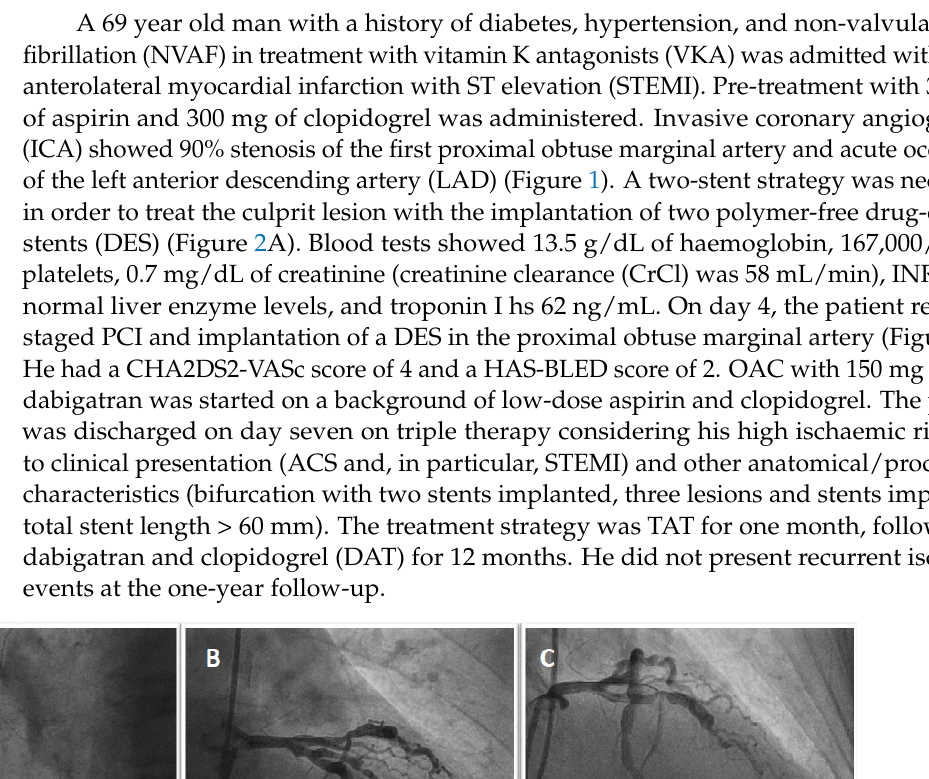
Figure 2. Final result after the first intervention with the implantation of two polymer-free DES on the mid-LAD and second diagonal branch (T stent technique; 2.75 × 24 mm and 2.25 × 14 mm) ( A ). Final result after the second intervention with implantation of a DES in the proximal obtuse marginal artery (2.5 × 25 mm) ( B ). 1.2. Patient 2 A 68 year old female presented with stable angina Canadian Cardiovascular Society (CCS) grading III and positive stress-echocardiography was referred to ICA. She had not well-treated hypertension, hypercholesterolemia, and chronic kidney disease (CKD). She also reported a history of palpitations and, 3 years before admission, an episode of melena. Laboratory data showed 10 g/dL of haemoglobin, 155.000/mL of platelets, 1.2 mg/dL of creatinine (ClCr was 35 mL/min), and normal liver enzyme levels. The transthoracic echocardiography (TTE) demonstrated left ventricular hypertrophy (LVH) in the presence of normal ejection fraction (EF), mild left atrial (LA) dilation, and mild mitral regurgitation (MR). She underwent ICA, which revealed a significant lesion of a large diagonal branch treated with PCI and implantation of one DES (Figure 3).